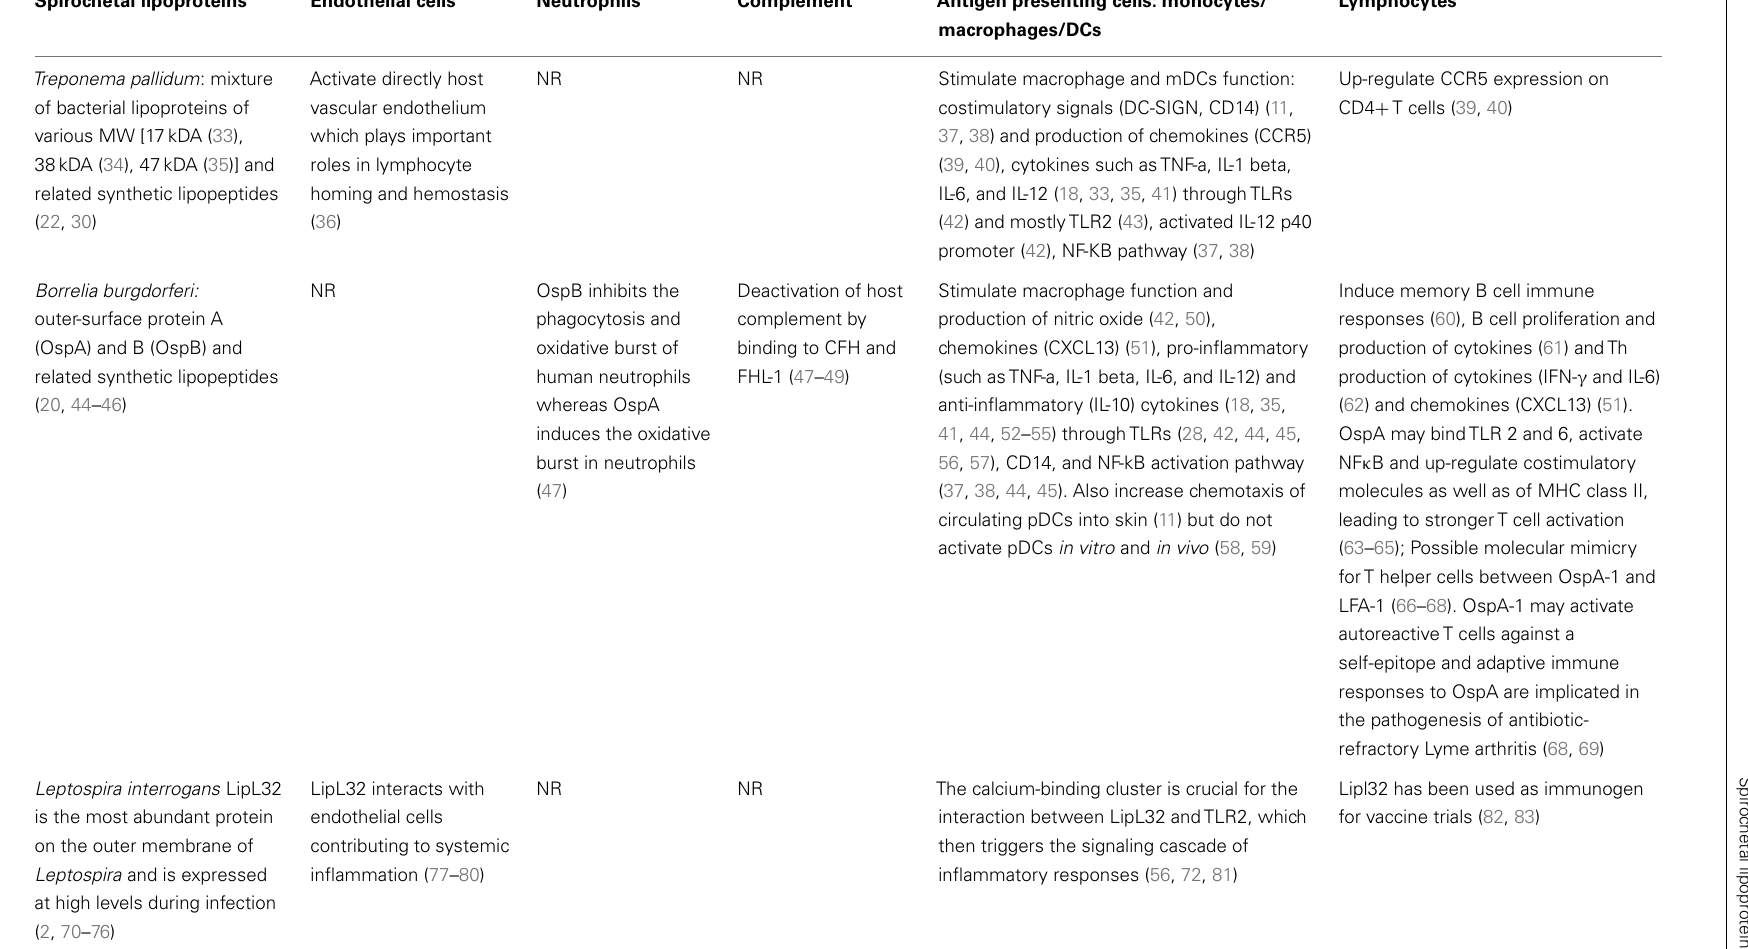
Table 1 | Immunoregulatory effects of major known spirochetal lipoproteins . Spirochetal